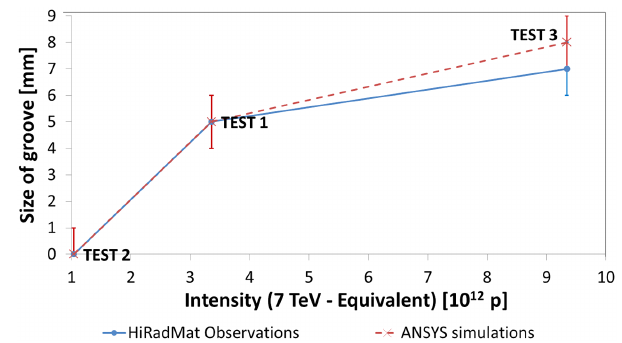
FIG. 24. Summary plot with a comparison of the damage extent between the observed and simulated values for the three